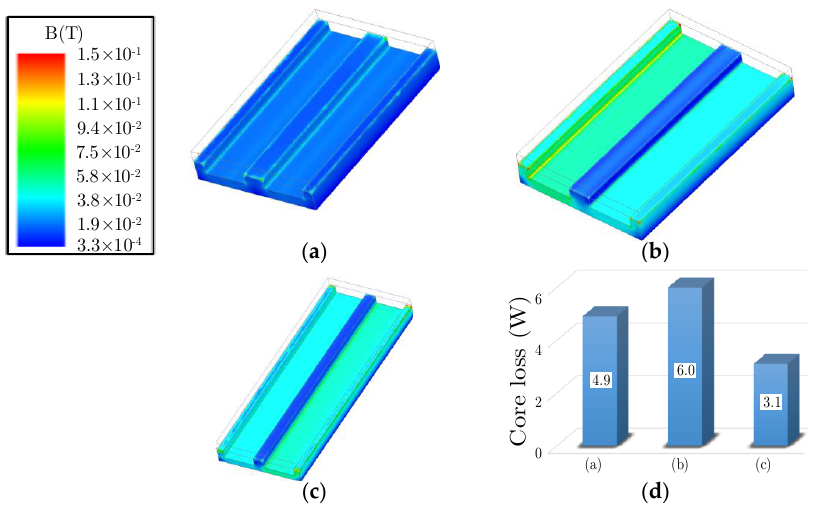
Figure 13. Simulation results: ( a ) conventional design; ( b ) unoptimized design of the proposed integrated magnetic structure; ( c ) optimized design of the proposed integrated magnetic structure; ( d ) power loss comparison.